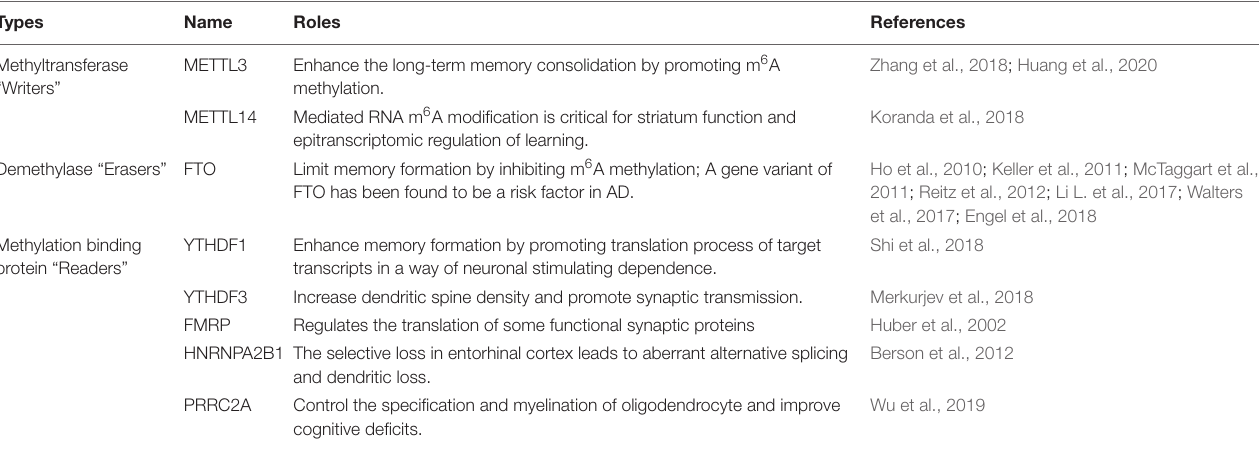
TABLE 1 | The function of RNA N6-methyladenosine methylation modification enzyme in learning and